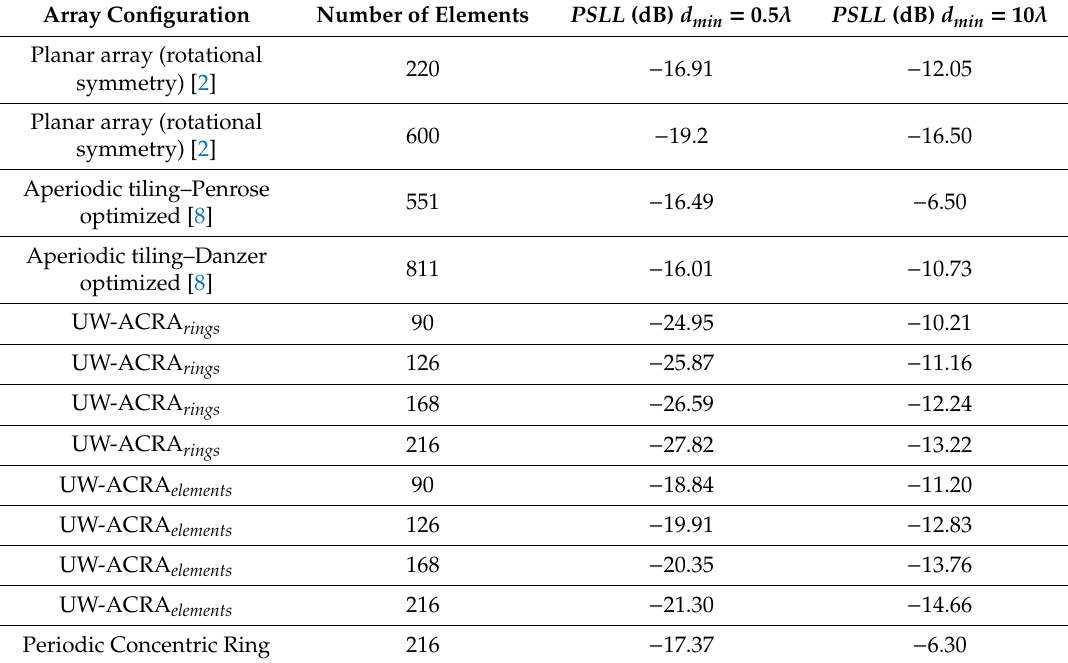
Table 1. Performance summary of the design cases UW-ACRA elements and UW-ACRA rings and a comparison with respect to previous